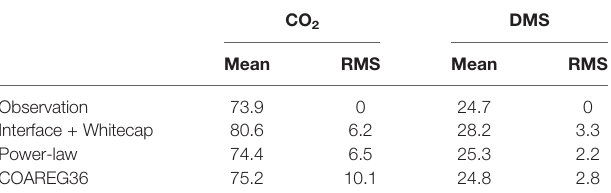
TABLE 2 | Summary of mean k 660 (cm hr -1 ) and RMS difference from mean HiWinGS measurements.